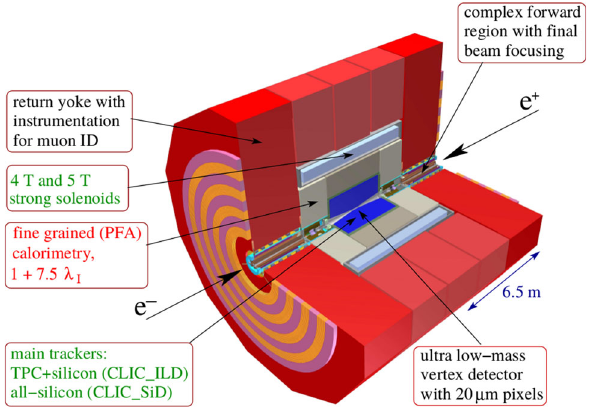
Fig. 1 Schematic diagram for the CLIC detector (taken from an older version [38])